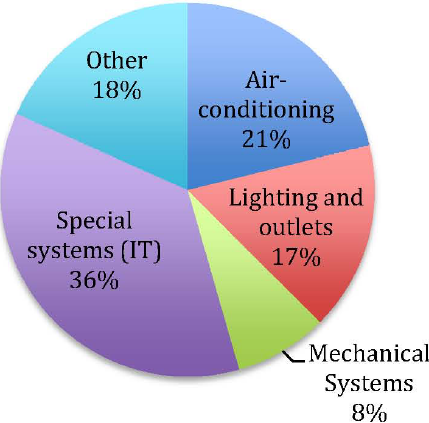
Figure 6. Shenzhen IBR annual energy end uses (2012).